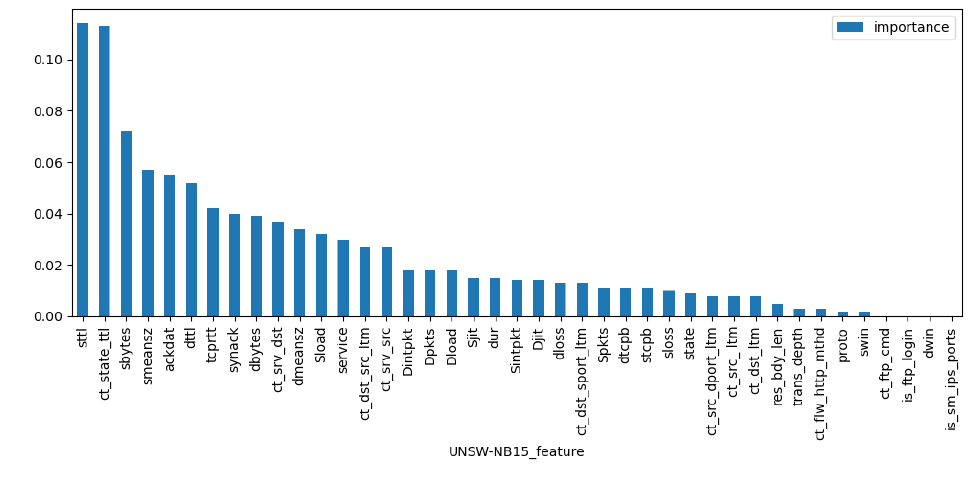
Figure 8. Feature importance of UNSW-NB15.